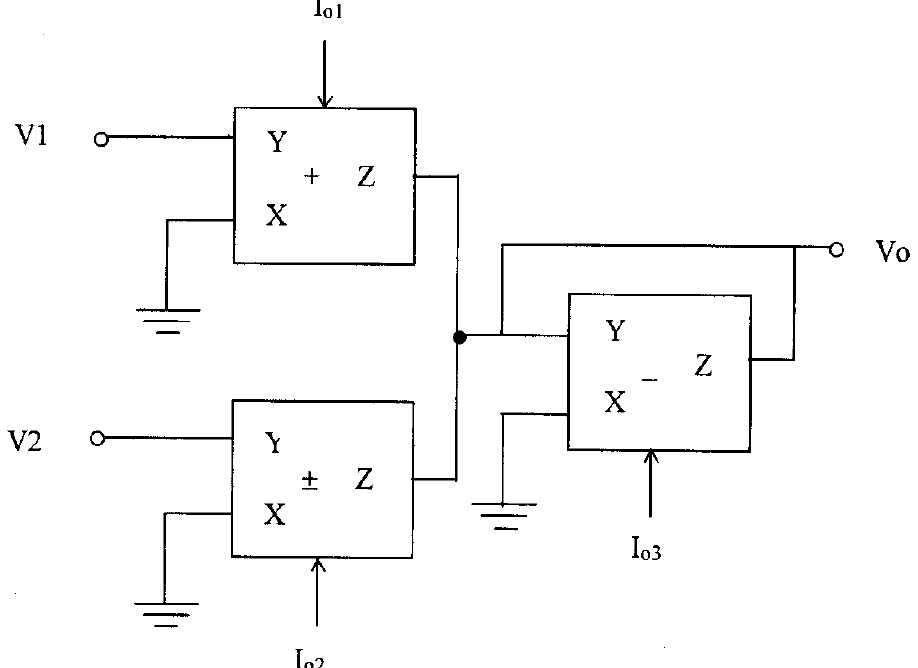
FIGURE 1 Proposed active-only summing = difference